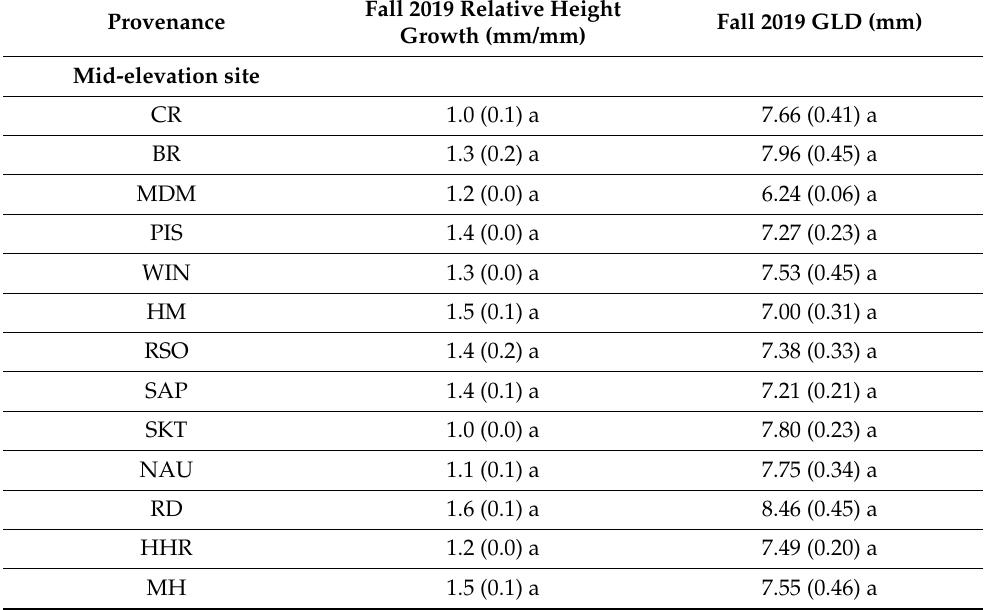
Table 2. Provenance relative height growth ((Fall 2019 height—Height at planting)/Height at planting) and ground line diameter (GLD) at mid- and high-elevation sites (ordered by increasing elevation). Values are means (1 SE); NA indicates SE not calculated due to low survival in most blocks. Means in the same column followed by the same letters do not differ significantly (Tukey’s HSD tests; α = 0.05).